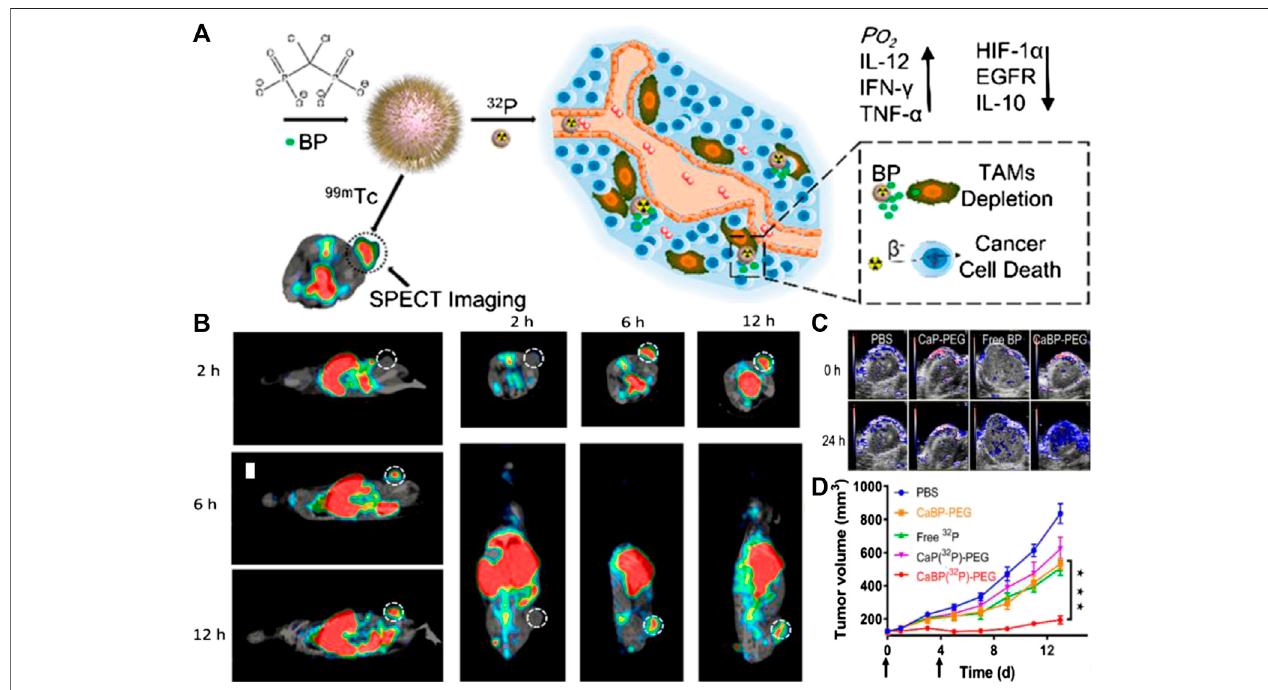
FIGURE 8 | (A) Calcium bisphosphonate (CaBP-PEG) nanoparticles for chelator-free radiolabeling chemistry, effective in vivo depletion of TAMs, and imaging- guided enhanced cancerradioisotope therapy (RIT). (B) SPECT images of mice at 2, 6, and 12 h after intravenous injection of CaBP( 99m Tc)-PEG nanoparticles. Tumors of mice are highlighted by the dotted circles. (C) Photoacoustic imaging showing tumor saturated O 2 levels of mice after i.v. injection of PBS, CaP-PEG, free BP, or CaBP-PEGnanoparticles. (D) Tumorvolumecurvesofmicewithvarioustreatments.Dosesforeachinjection:100 μ Ciof32P,200 μ gofBP.Themiceweretreated twice at day 0 and 4 (black arrows). Reproduced with permission from Chen J. et al. (2019). Copyright 2018 American Chemical